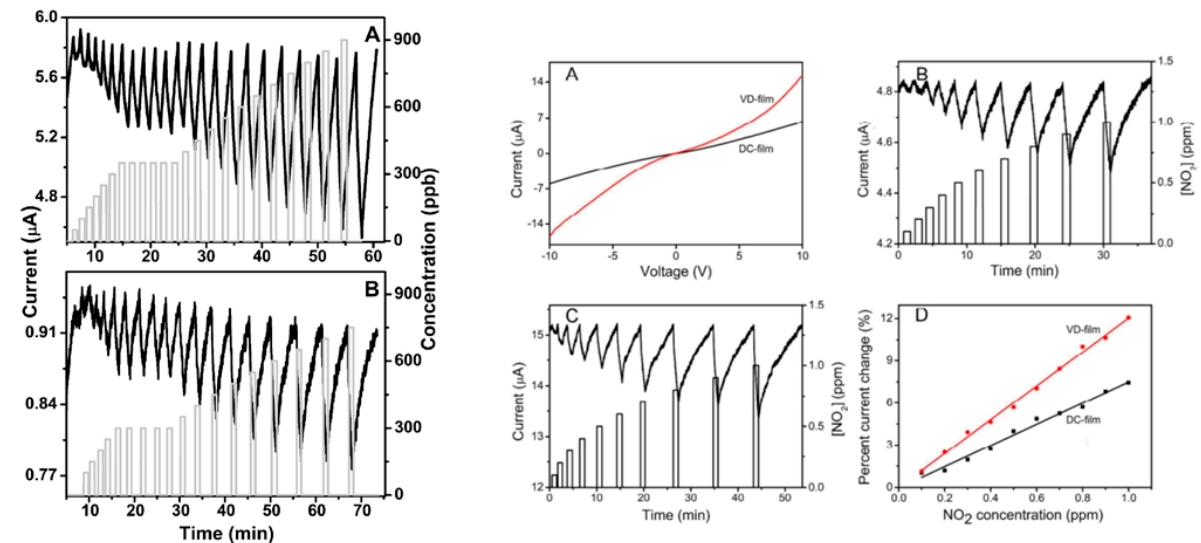
Figure 10. ( left ) Time-dependent current plots for the microribbons of H 2 [Pc(OCH 2 C 3 F 7 ) 8 ] ( A ) and the nanowires of Zn[Pc(OCH 2 C 3 F 7 ) 8 ] exposed to NO 2 at varied concentration ( B ). Reprinted from [58] with permission from Elsevier. ( right ) I-V curves measured on the drop-casted (DC) film and the film deposited in vacuum (VD) ( A ); the time-dependent current plot of sensor as a function of the NO 2 concentration in N 2 atmosphere for the DC film ( B ), and the VD film ( C ); and the sensor response varies linearly with NO 2 concentration of the DC film and the VD film ( D ). Reprinted from [57] with permission from Royal Society of Chemistry.